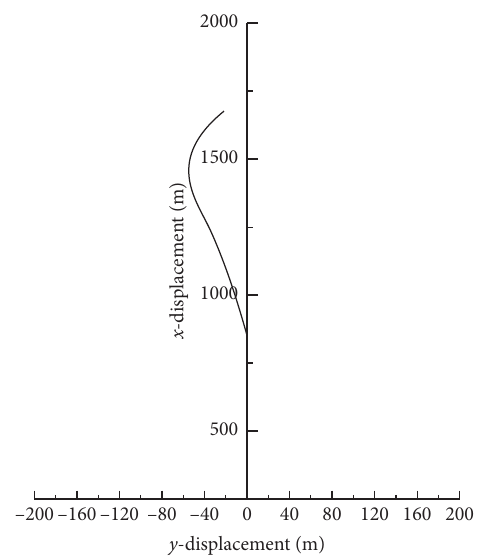
Figure 19: Trajectory for a rudder angle of 15 ° and a ship speed of 26km/h.